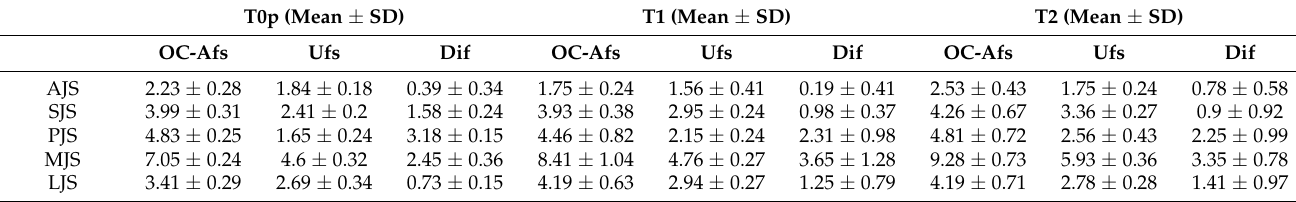
Table 5. Different joint space measurements at T0p, T1, and